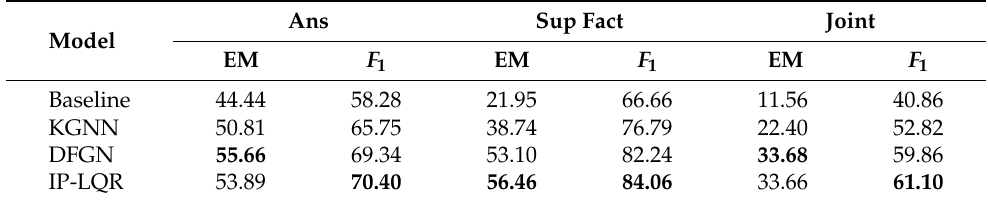
Table 2. Performance results of comparing methods. Ans denotes answer accuracy, Sup Fact denotes the support paragraphs accuracy and Joint denotes the accuracy where the answer and support paragraphs are all correct. The bold denotes the best result in each